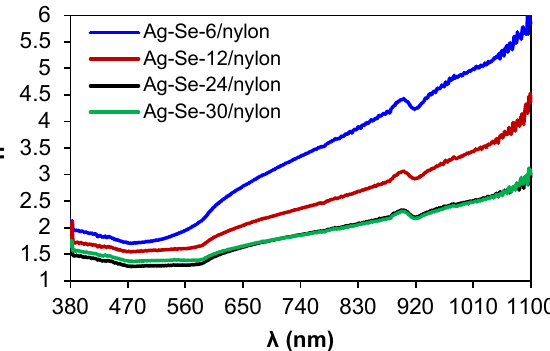
Figure 9. Variation of refractive indices of Ag–Se/nylon nanocomposites on wavelength.